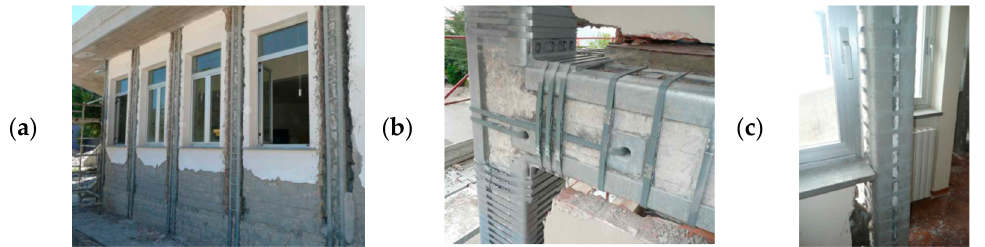
Figure 1. Images of a typical ACM-based retrofit intervention on a building with RC frame structure: view of a façade ( a ), a beam-to-column joint ( b ), and a column situated in proximity to two windows ( c )—pictures taken from [50].